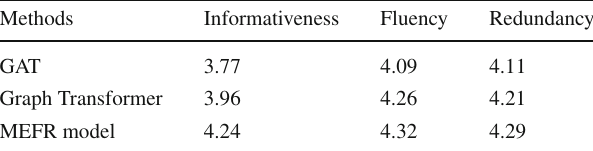
Table 5 Human evaluation results